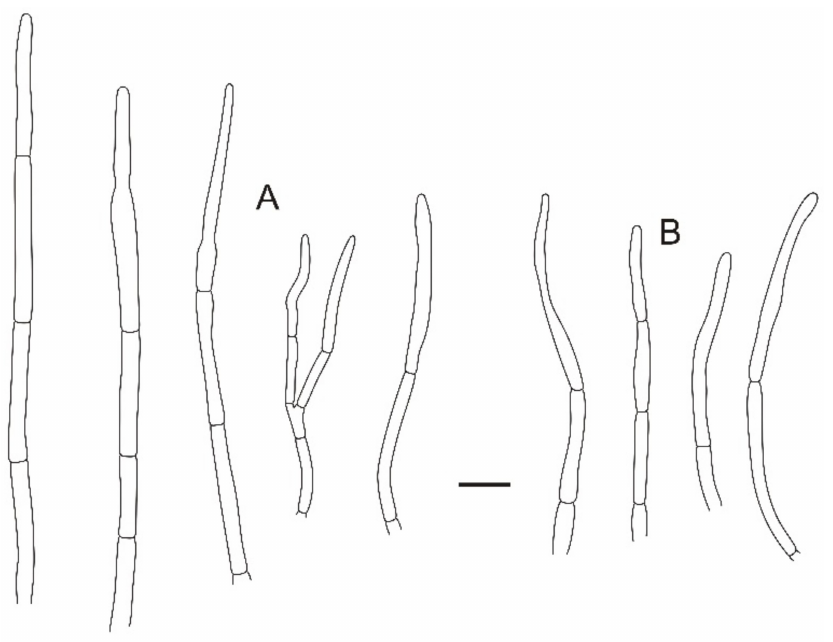
Figure 17. Microscopic features of Russula sinorobusta (BJTC Z052). ( A ) Hyphal terminations near the pileus margin. ( B ) Hyphal terminations near the pileus center. Scale bar: 10 µ